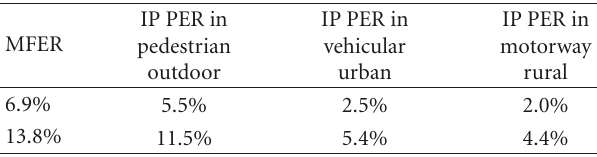
Table 2: IP PER at MFER 6.9% and 13.8% in three di ff erent channels.